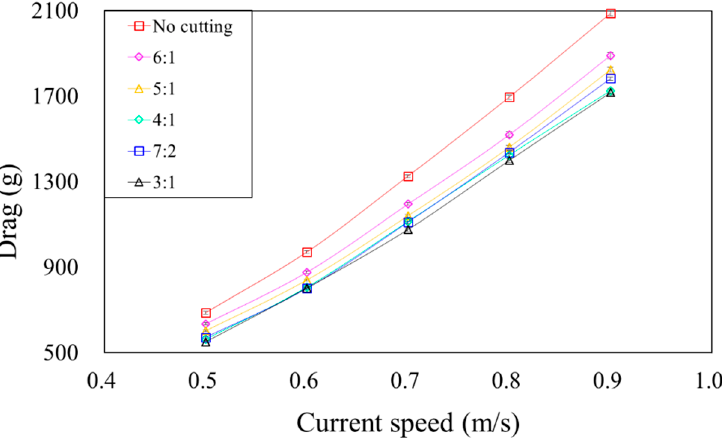
Figure 6. Drag of empty codends with different cutting ratio at 5 current speeds.